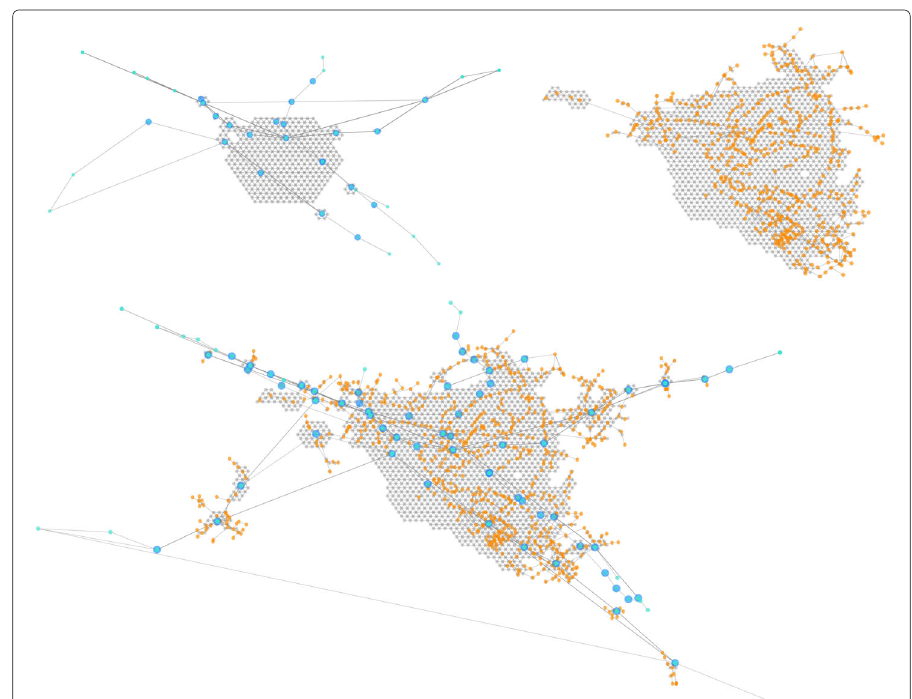
Fig. 6 The nodes reachable within 30 min for the rail (top-left), bus (top-right) and public transportation (bottom) networks for location #2621 shown at the same geographic scale